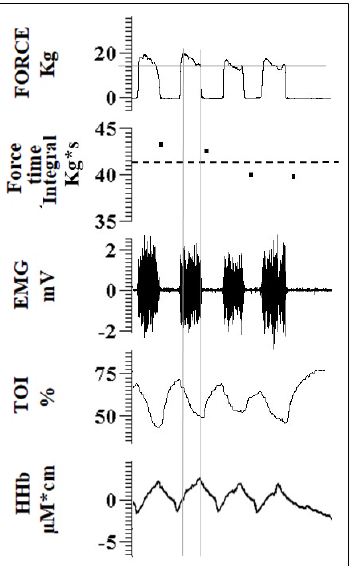
Figure 2. Signals during exercise. From top to bottom: Exerted force, the dotted line corresponding to 80% MVC—this signal was provided as visual feedback to the subject; force–time integral calculated in real-time over each single contraction, the dashed line corresponding to 90% of the expected force–time integral calculated over one contraction (=80% MVC * 3 kg*s) (see text)—this signal, checked by the experimenter, drops below the threshold if the force is too low and/or the duration of the contraction is too short; electromyographic (EMG) signal from the bicep muscle; tissue oxygenation in bicep muscle (TOI); changes in deoxyhemoglobin concentration (HHb). Vertical gray continuous lines indicate the interval from 0.5–3-s from the beginning of the contraction, used to calculate EMG and NIRS variables during exercise.